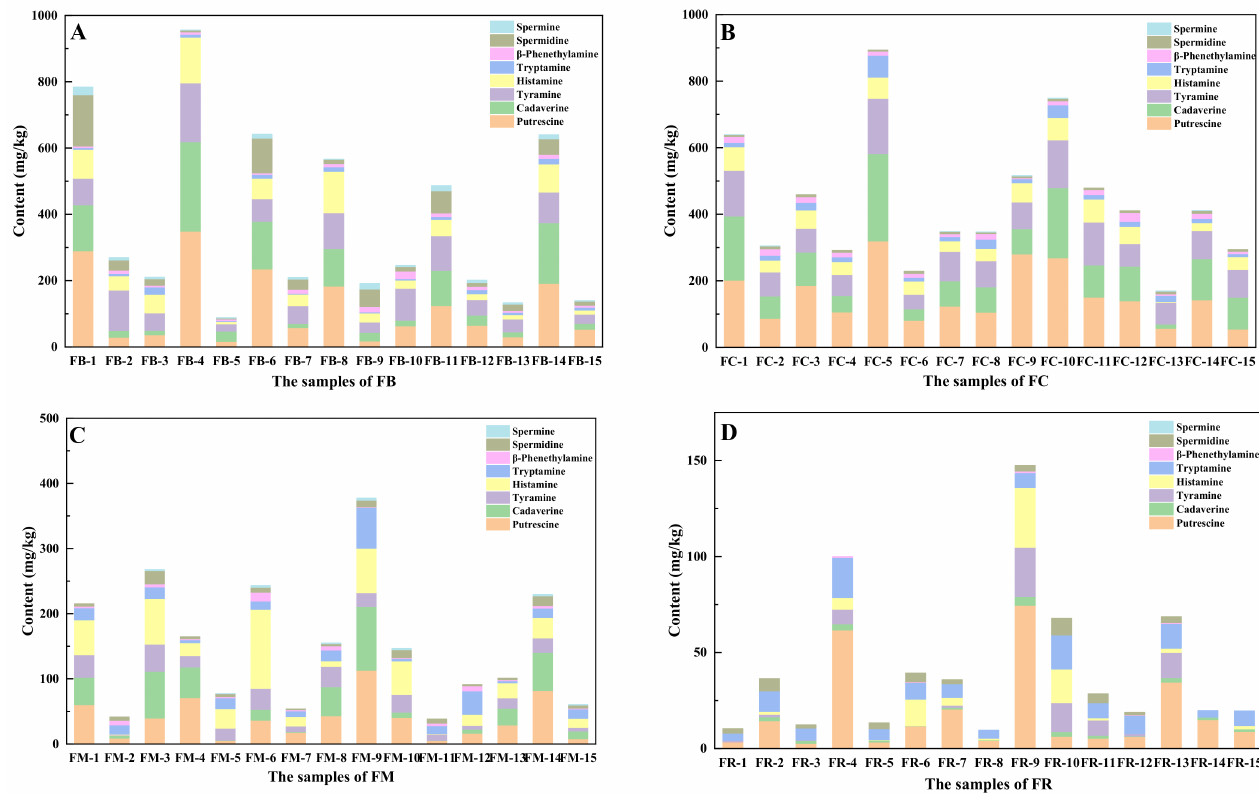
Figure 3. The concentration of biogenic amines in different types of fermented vegetables: ( A ) fermented bamboo, ( B ) fermented cabbage, ( C ) fermented mustard, and ( D ) fermented radish. FB, fermented bamboo; FC, fermented cabbage; FM, fermented mustard; FR, fermented